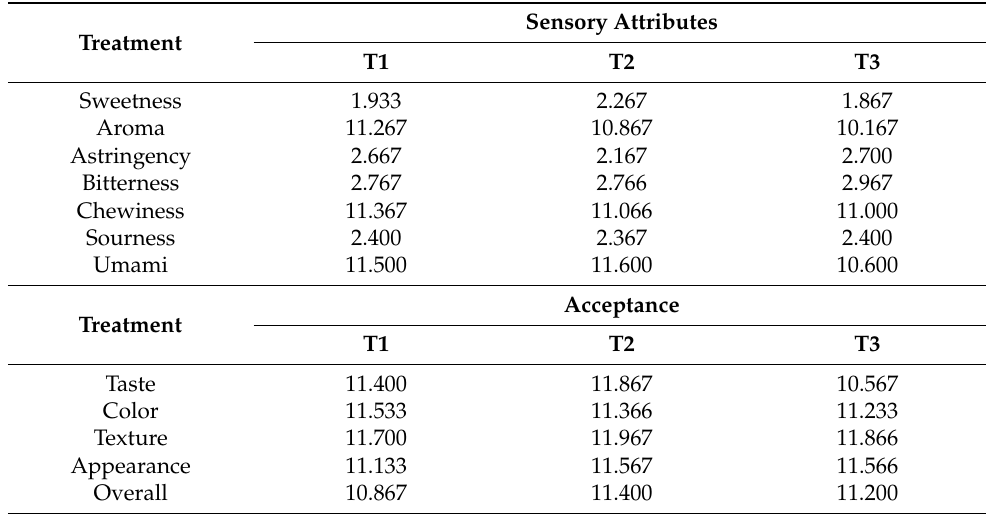
Table 3. Sensory attributes and acceptability parameters evaluated in the consumer test.